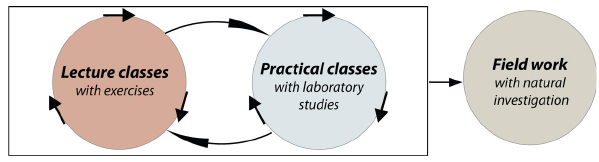
Fig. 2. The adapted iterative loop structure over the three class com- ponents for an integrated pedagogy for the presented course devoted to groundwater flow processes. At first, the students progress within a cycle between lecture class and practical class. Once this cycle ends, the students are taken in the field and investigate an applied